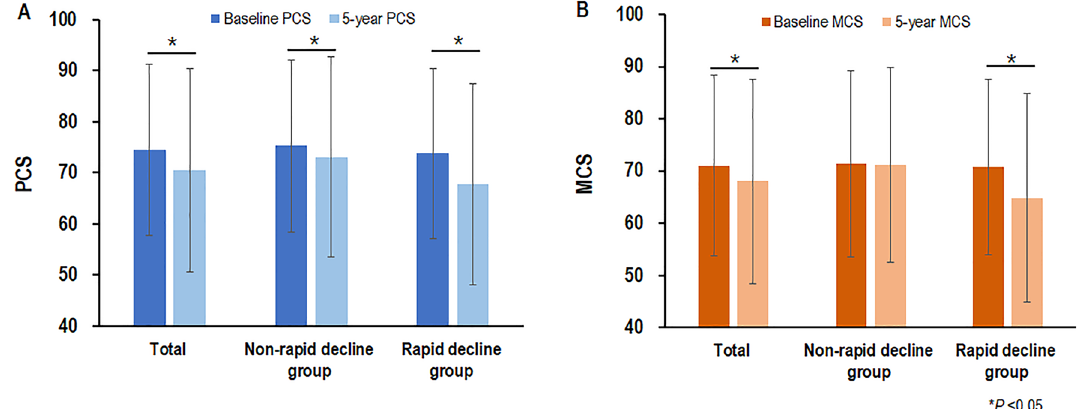
Figure 2. HRQOL changes according to the presence of a rapid decline in kidney function after propensity score matching. ( A ). The PCS score was significantly decreased in both the non-rapid ( P = 0.012) and rapid ( P < 0.001) kidney function decline groups. ( B ). The MCS score was significantly decreased in the rapid kidney function decline group alone ( P < 0.001). HRQOL, health-related quality of life; PCS, physical component summary; MCS, mental component